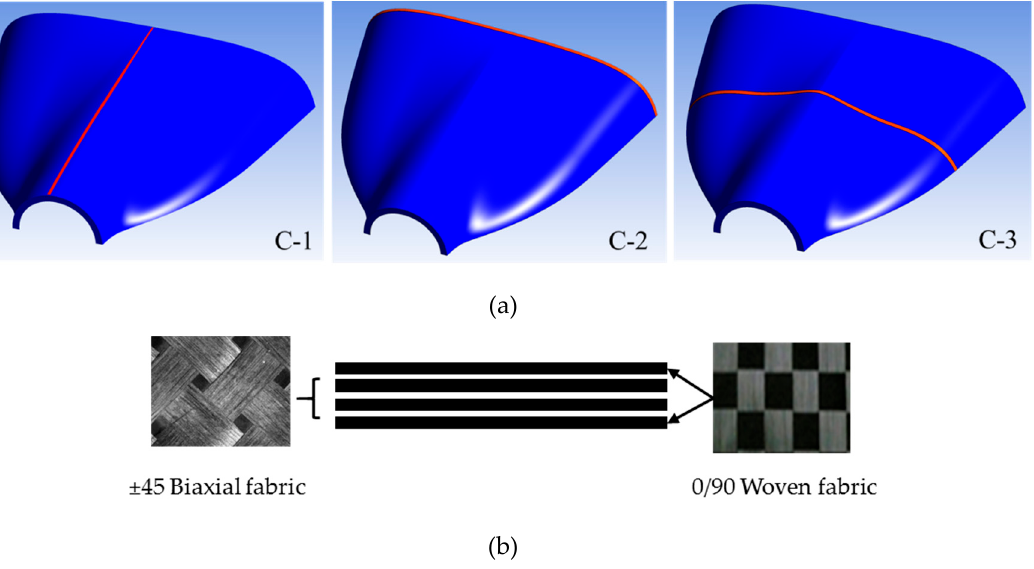
Figure 3. ( a ) Geometry of the aircraft upper cowling; ( b ) Laminate code.